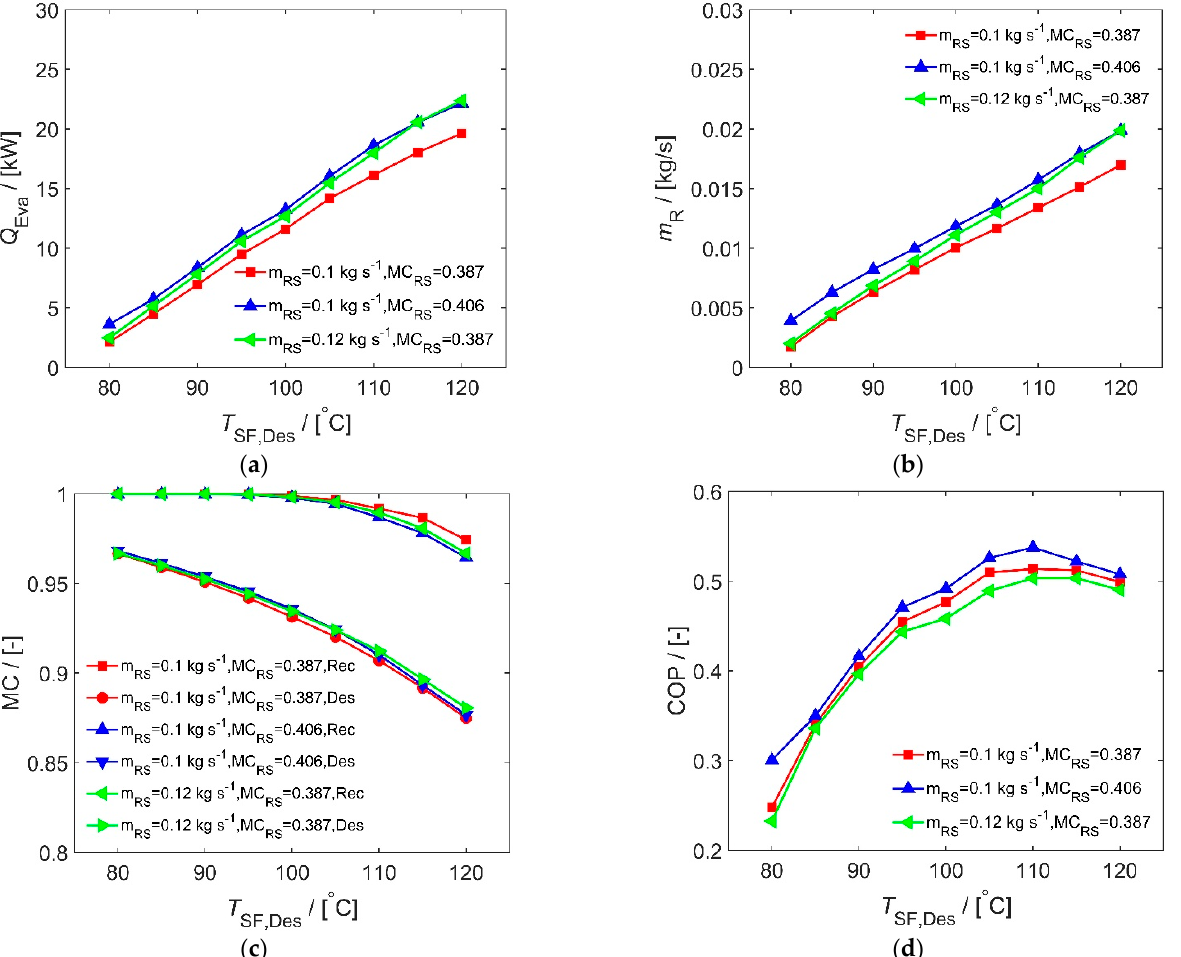
Figure 7. Performances of basic cycle as a function of heat source temperature, the mass flow rate and mass concentration of the rich solution. Cycle performances are ( a ) Cooling capacity, ( b ) Refrigerant mass flow rate, ( c ) Vapour mass concentration at the outlet of the desorber and rectifier, ( d ) COP.